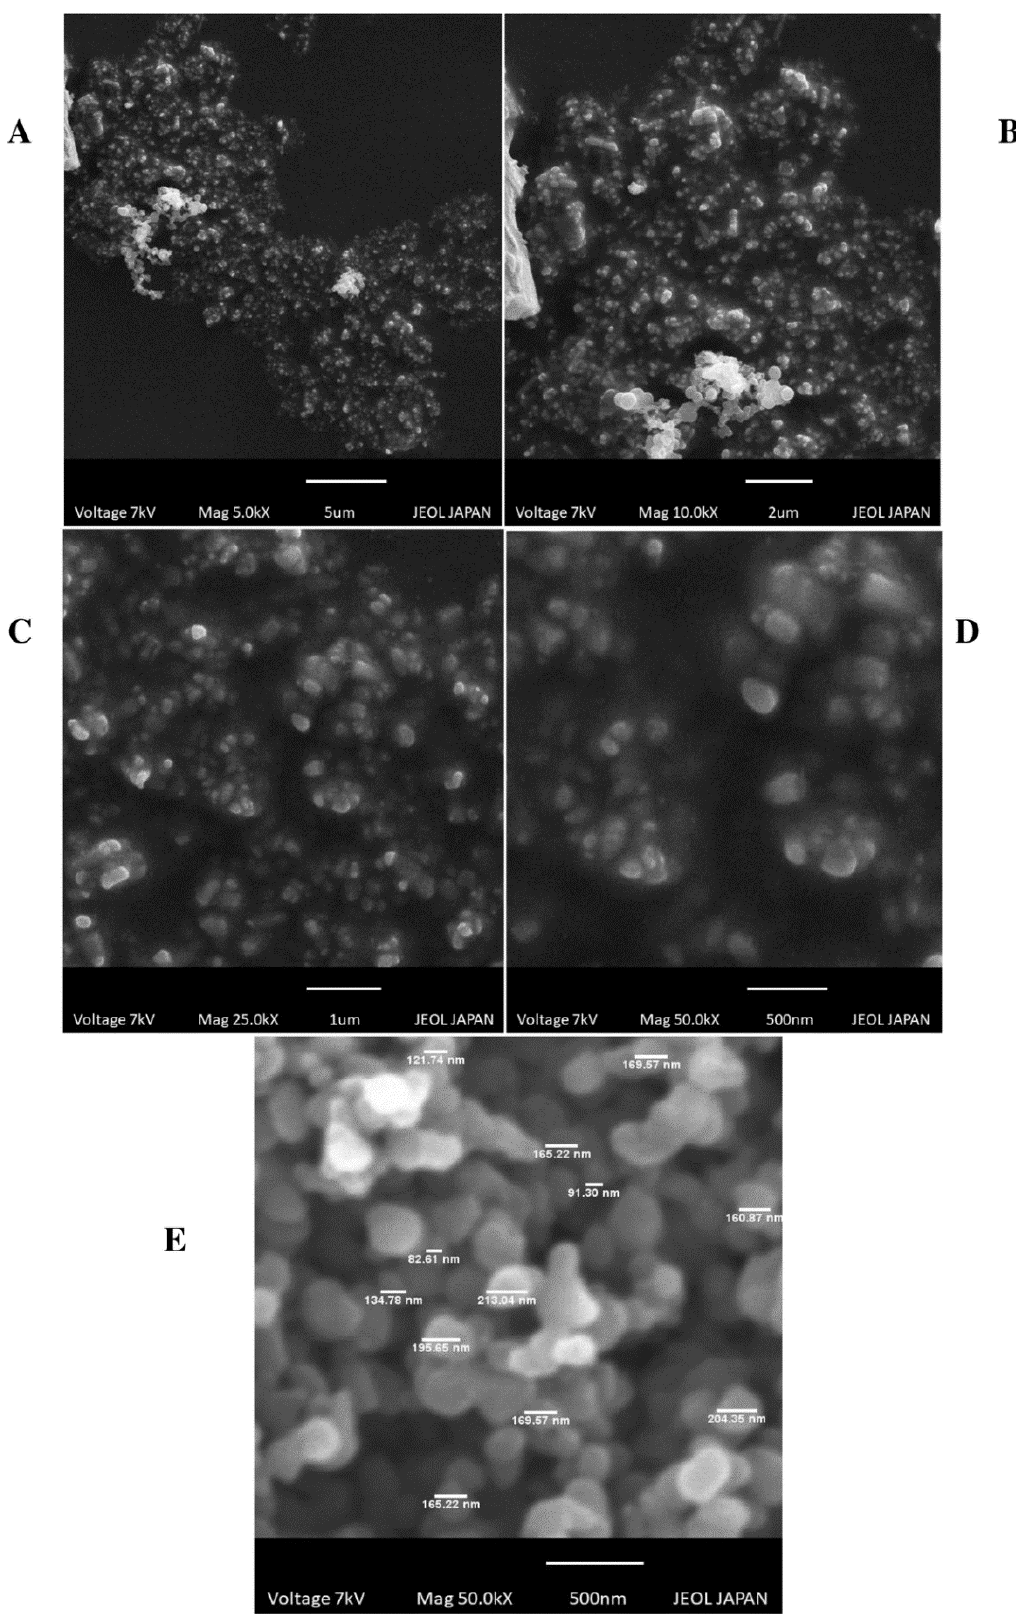
Figure 3. SEM images of AF6 at magnification ( A ) 5 kX ( B ) 10 kX ( C ) 25 kX ( D ) 50 kX ( E ) Individual particle size determination of ALP ‐ SLNs by Image J sizer.